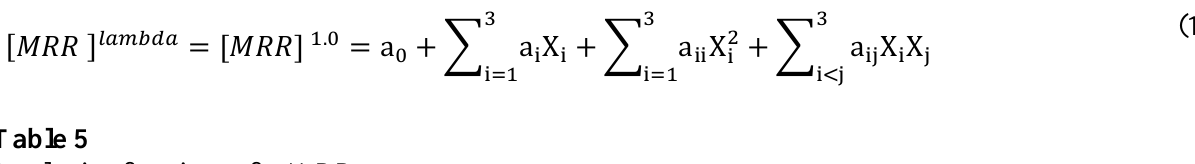
Analysis of variance for MRR